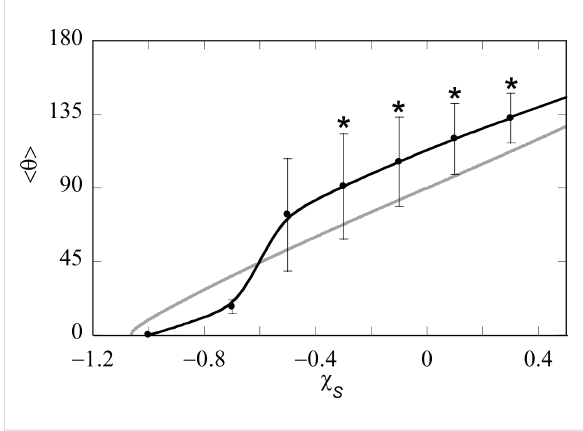
that for this case